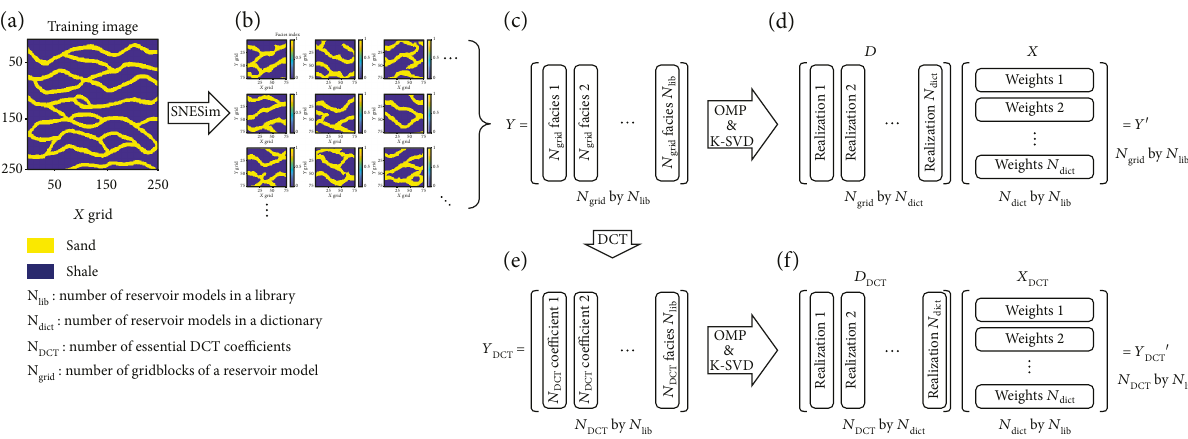
Figure 7: Construction of sparse geologic dictionaries using K-SVD without and with DCT: (a) training image, (b) generation of the initial channel models ( Y ) using SNESIM, (c) organization of the models in a matrix, (e) transformation of Y into DCT coe ffi cients, and construction of D and X from Y using K-SVD in (d) facies domain and (f) in DCT